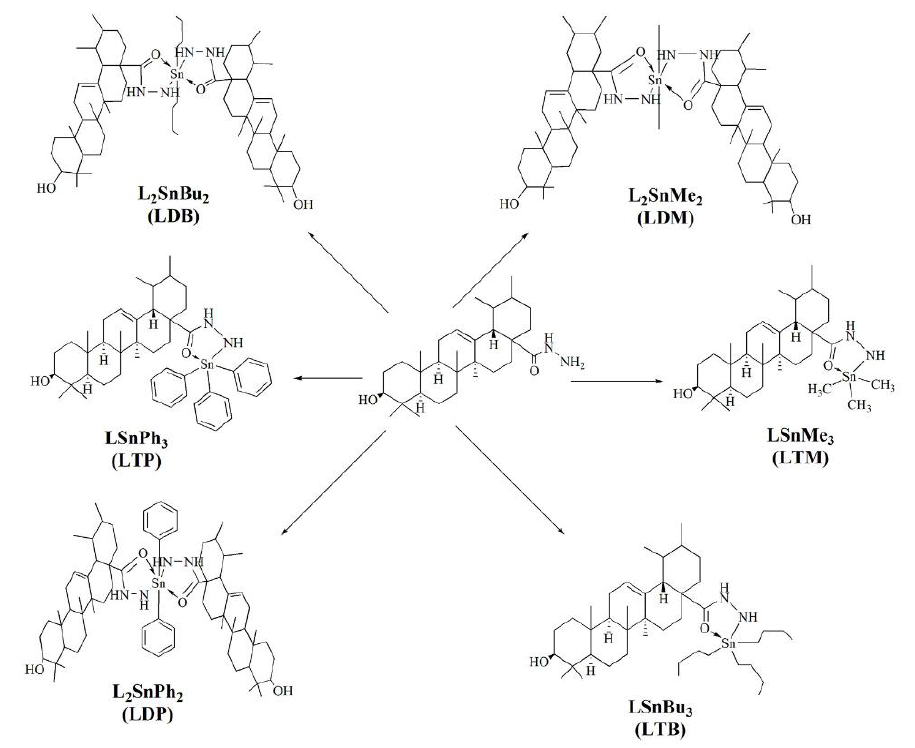
Figure 10. Synthesis of ursolic acid-tin complexes [63].